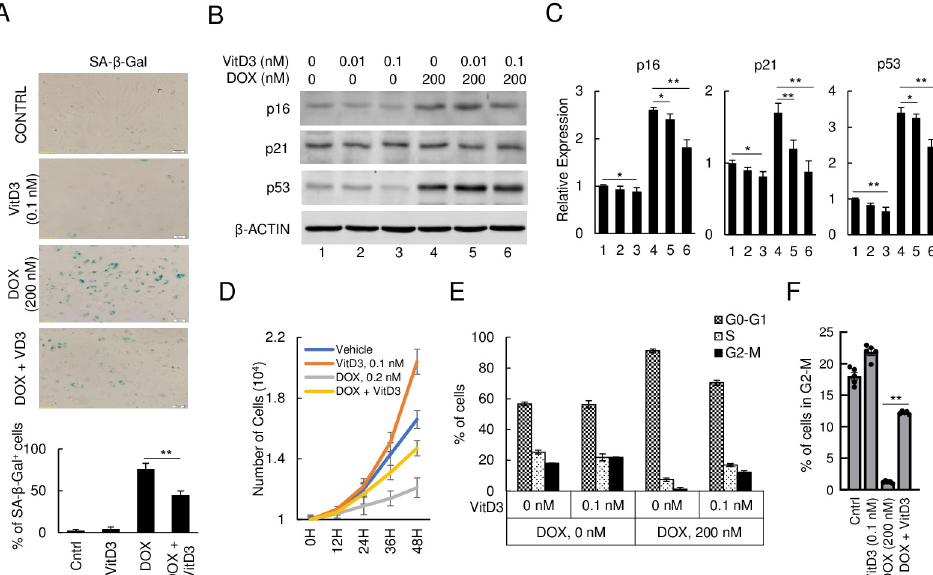
Fig 2. VitD3 attenuates DOX-induced senescence and cell amplification of HAECs. (A) SA- β -Gal staining of senescent HAECs after DOX or/and VitD3 treatment. Scar bar, 20 μ m, ( �� p < 0.01, n = 3). (B) Immunoblot of p16, p21, and p53 on DOX and VitD3 cotreated HAECs. (C) Quantitative representation of the relative expression levels to the immunoblot ( � p < 0.05, �� p < 0.01, n = 3). (D) Cell amplification after DOX and/or VitD3 treatment and quantified the number of cells. (E) Cell cycle analysis by flow cytometry after DOX and/or VitD3 treatment. (F) Percent of cells on the G2-M stage during cell cycle analysis ( �� p < 0.01, n = 5).